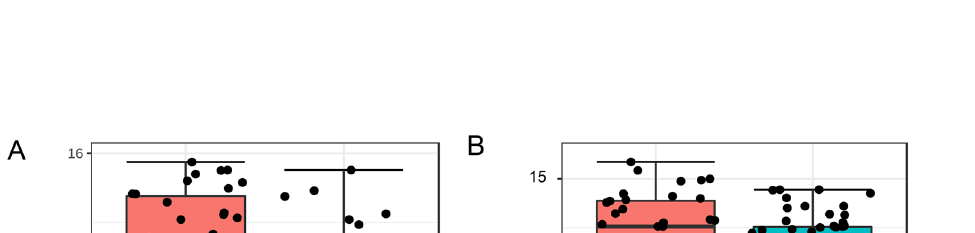
Figure 2. ( A ) Relative abundance bar plot showing the five most abundant bacterial phyla, averaged across all samples within each subpopulation (East Greenland [EG] and Southern Beaufort Sea [SB]) and ( B ) Relative abundance bar plot showing the eight most abundant bacterial classes, averaged across all samples within each subpopulation.